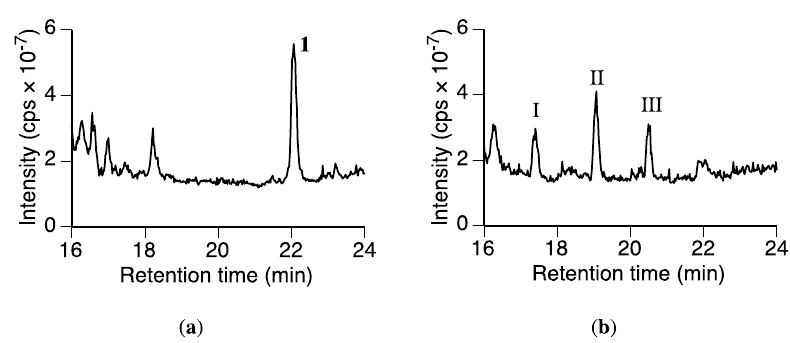
Figure 3. Total ion current chromatograms obtained from the Rhizoctonia solani suspension cultures containing sakuranetin ( 1 ) using LC-MS. ( a ) Chromatogram after 0 h of incubation following the addition of 1 ; ( b ) 12 h of incubation after the addition of 1 .